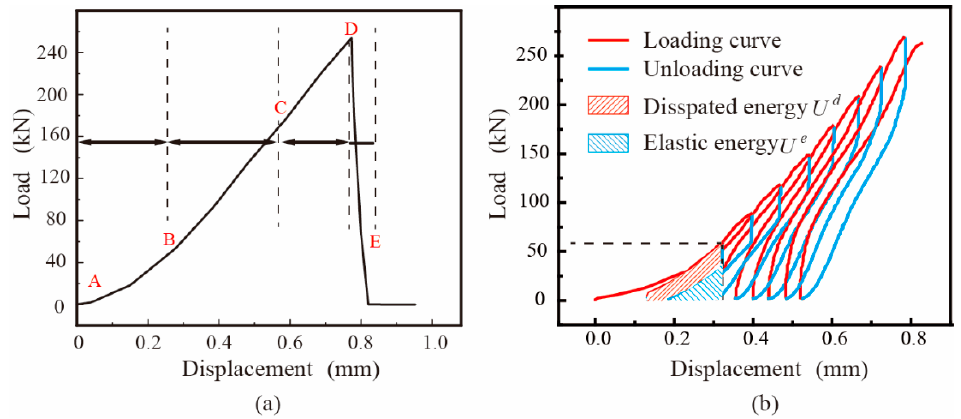
Figure 3. The uniaxial compression load-displacement curve ( a ) Different stages of uniaxial compression ( b ) Calculation of elastic energy and dissipation energy.